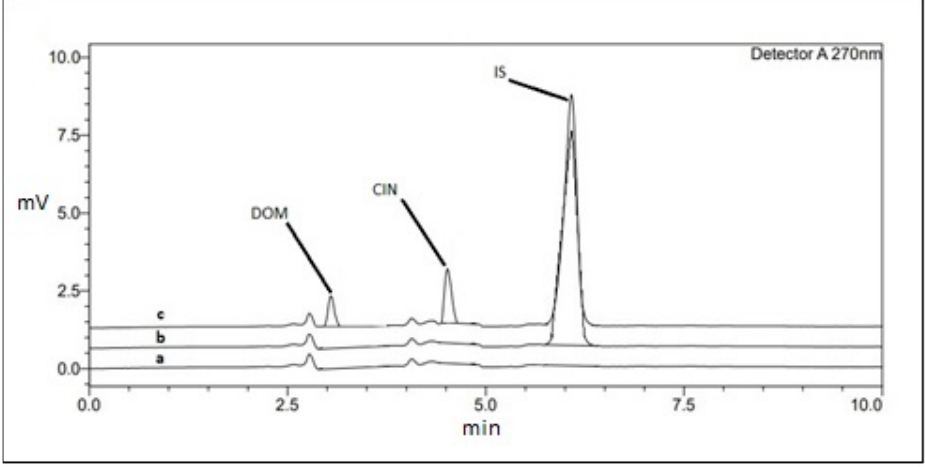
Figure 3. RP-HPLC chromatographs of (a) blank rat plasma, (b) blank rat plasma spiked with IS and (c) blank rat plasma spiked with CIN and DOM at LLOQ (5 ng/mL) and IS.